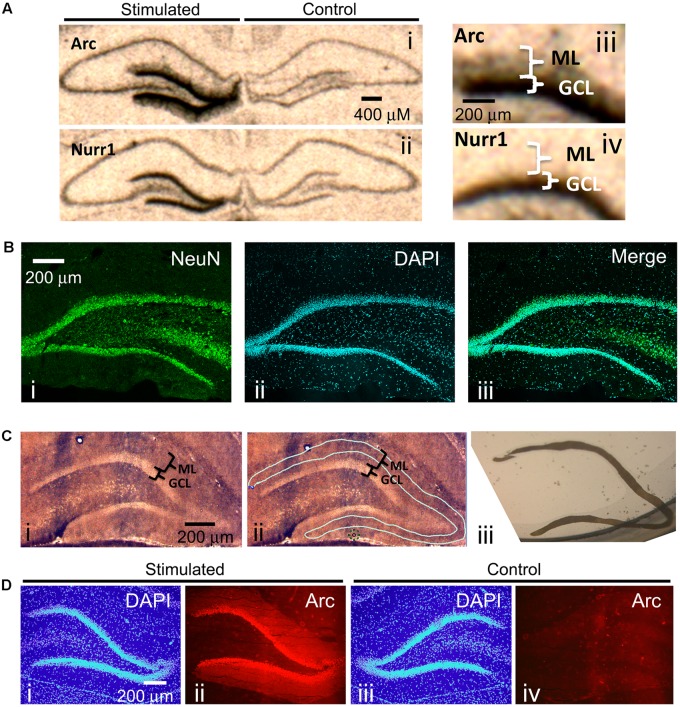
(A) Radioactive In situ hybridization of the immediate early genes (IEGs) Arc (i, iii) and Nurr1 (ii, iv) following unilateral pp-HFS to demonstrate robust presence of Arc mRNA in the ML 1 h following stimulation. Stimulated side indicates the side of the brain that received pp-HFS prior to sacrificing the rat. (B) A NeuN stain was performed to show the abundance of neuronal cell bodies in the GCL and their absence in the ML. A coronal section was stained for (i) NeuN and (ii) Dapi. (iii) A merge of NeuN and DAPI depicts the lack of NeuN positive cell bodies within the ML. (C) (i) A section containing the DG that was prepared for LMD. (ii) The same section is traced for the desired tissue sample of the ML prior to dissection. (iii) An image of the dissected ML tissue following LMD. (D) Confirmation of successful pp-HFS via Arc IHC. Staining of (i) DAPI and (ii) Arc protein on the stimulated side depicts robust localization of Arc to the ML compared to the contralateral/non-stimulated hemisphere (iii,iv), respectively.